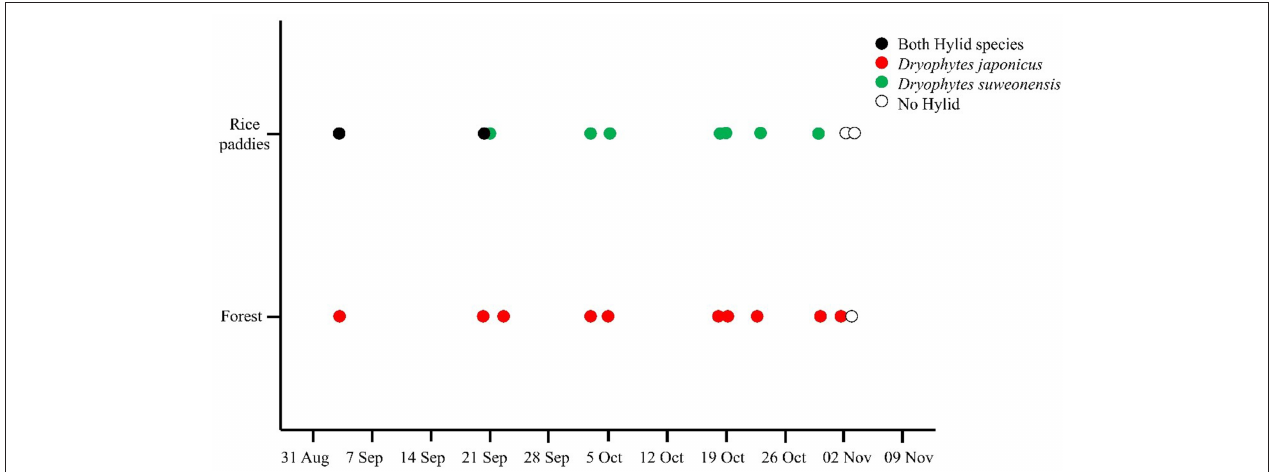
FIGURE 3 | Differences in habitat use by the two Dryophytes species during the brumation period as recorded during field observations (1) at two localities in 2014 ( n = 29) and four localities in 2015 ( n = 32). Dryophytes japonicus is present at both rice paddies and forests until late September, before habitat preferences diverged between the two species.